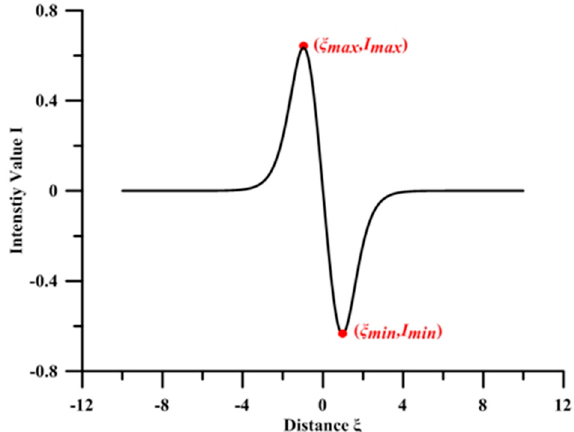
Figure 6. An example plot of the eKdV solitary wave in SAR images for A = − 1, B = 0, C = 0, γ = 1, Figure 6 . An example plot of the eKdV solitary wave in SAR images for 𝐴 = −1 , 𝐵 = 0 , and b = 𝐶 = 0 , 𝛾 = 1 , and 𝑏 = 0.5 .